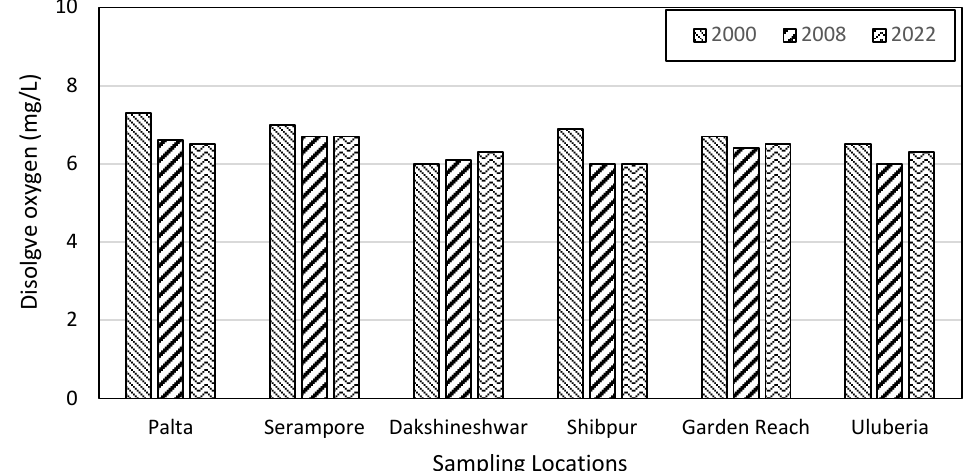
Figure 9. Variation of TDS in different locations.